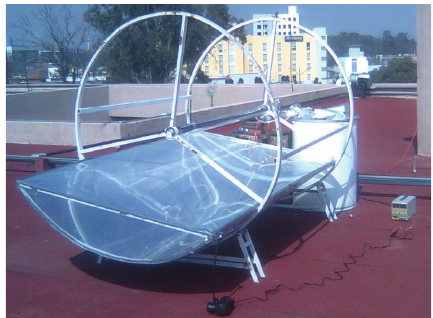
Figure 2: Cylindrical mirror wrapped with